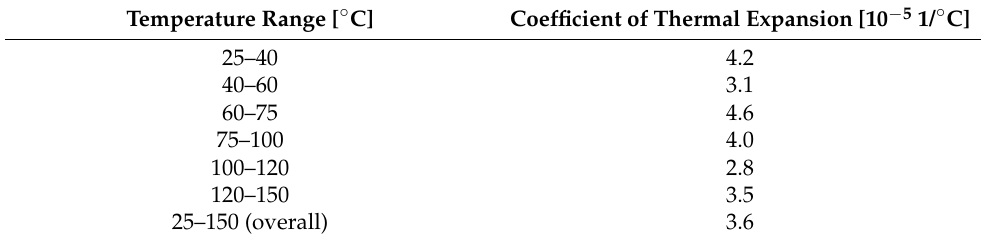
Table 1. Detailed CTE measurements for Onyx with 45 ◦ / − 45 ◦ infill from 25 to 150 ◦ C.